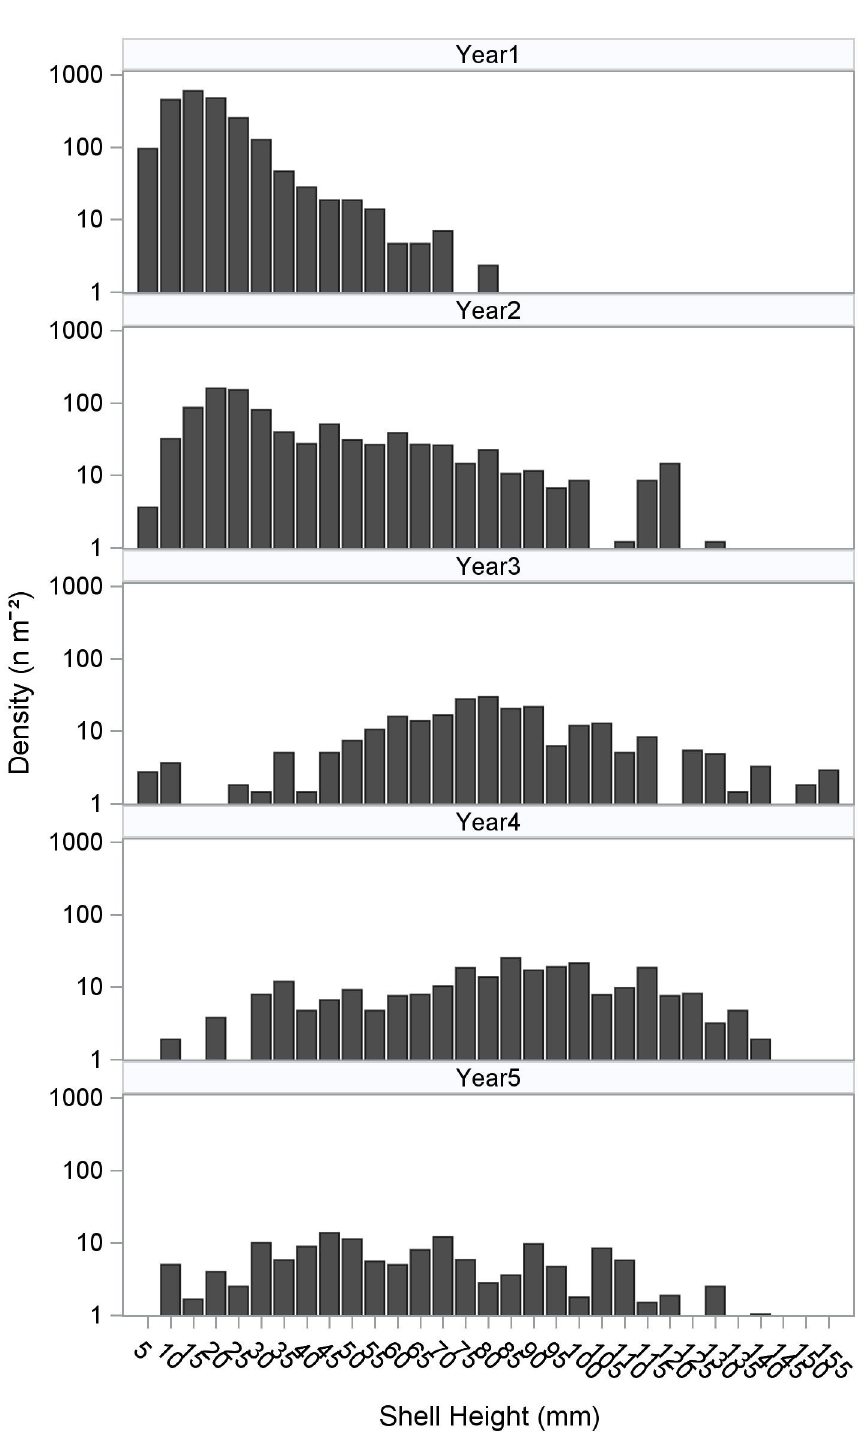
Fig 4. Size frequency distribution of oysters at constructed sites in years 1, 2, 3, 4, and 5 after reef construction.